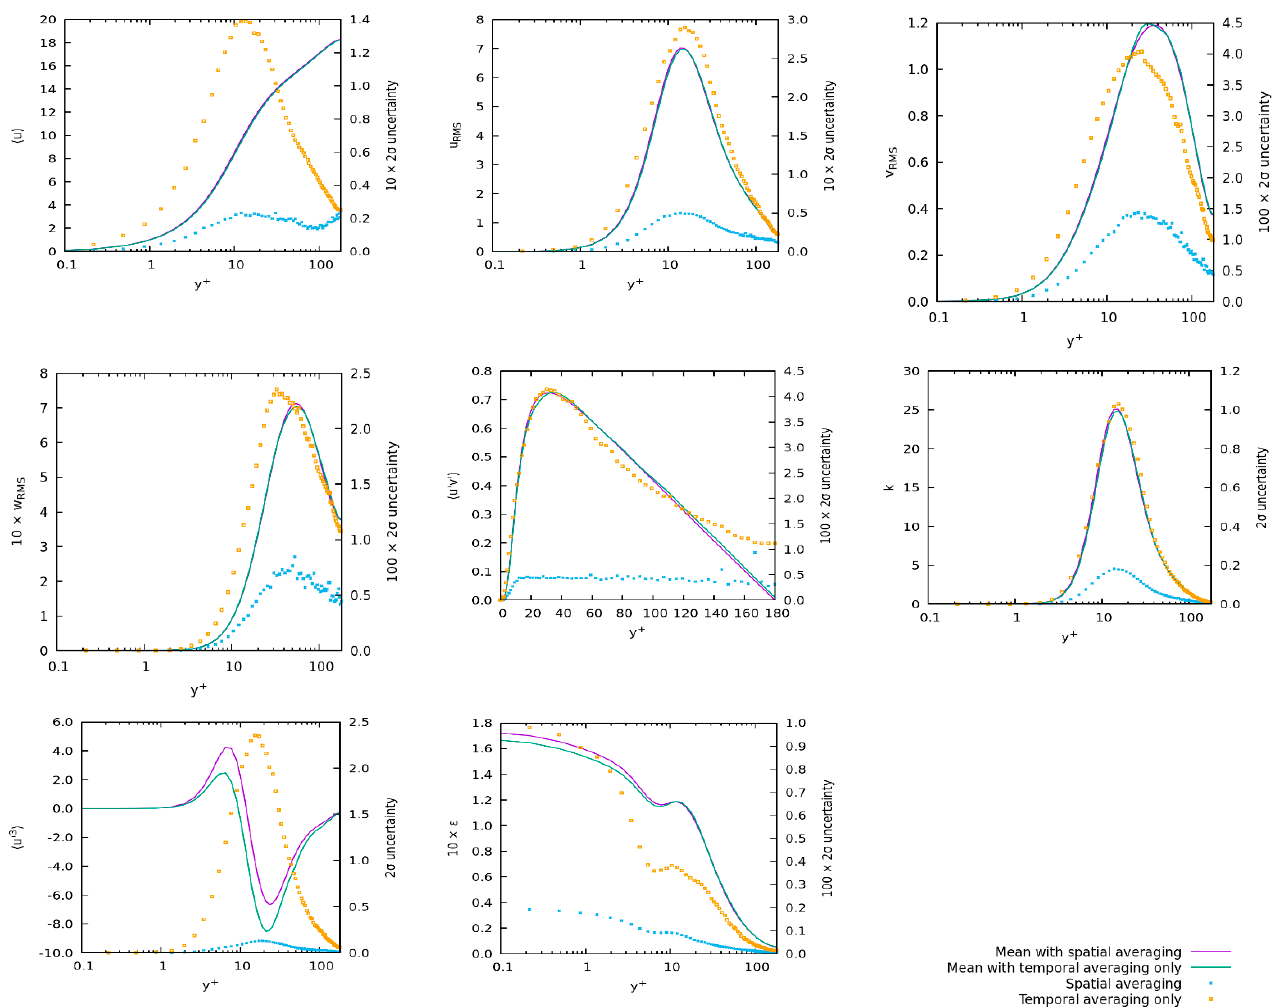
Figure 3. Various turbulence statistics (sloid lines, left scale) in channel flow with uncertainties (symbols; right scale). Table 1. Number of time steps used for integration. Monitor Points/Millions Profile Description Points